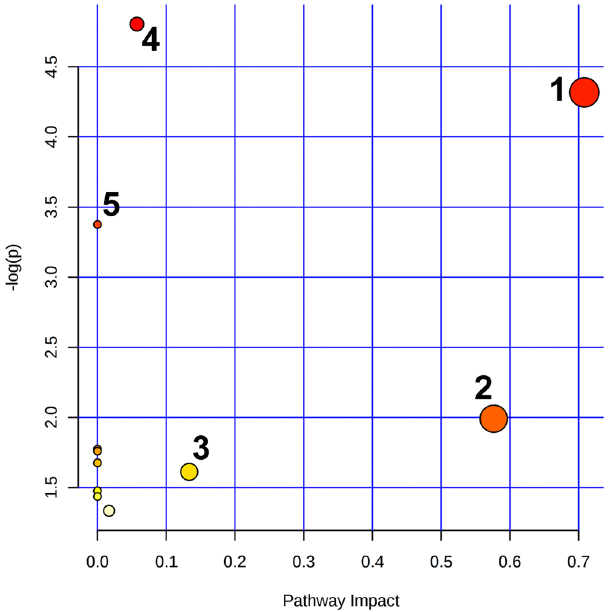
Figure 6. The joint pathway analysis revealing the metabolic pathways altered in the EG group. 1 - glycine serine and threonine metabolism; 2 - citrate cycle (TCA cycle); 3 - glutathione metabolism; 4 - glyoxylate and dicarboxylate metabolism; 5 - cyanoamino acid metabolism.